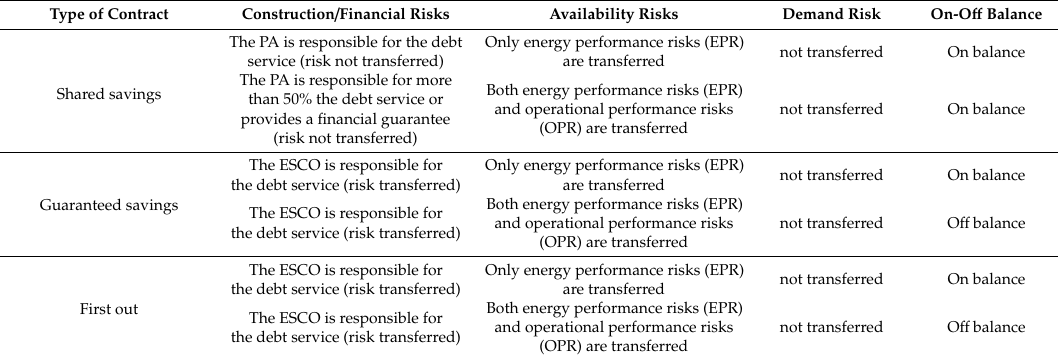
Table 1. Accounting treatment of energy performance contracting (EPC)-public private partnerships (PPPs) contracts according to risk